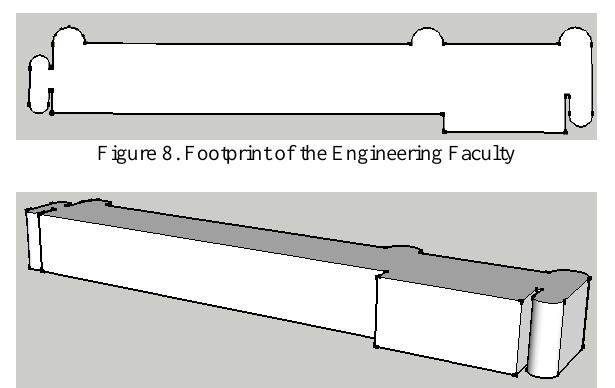
Figure 9. Extruding the footprint of the Engineering Faculty